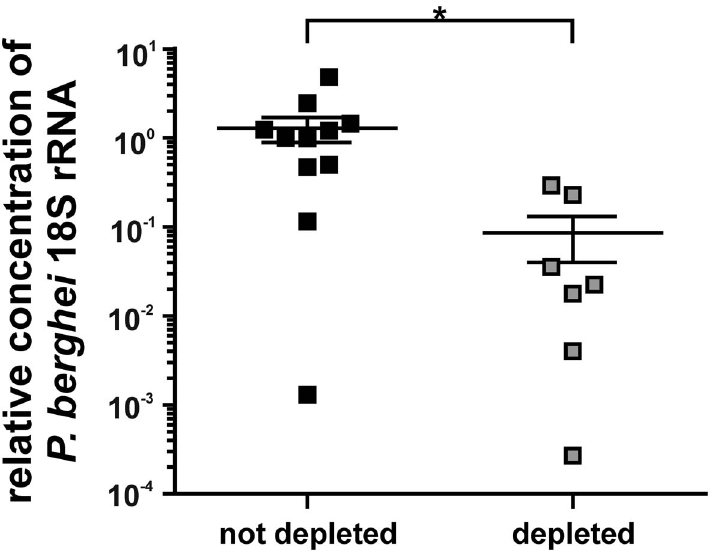
Figure 5. Impact of T reg depletion in parasite burden in the liver. Female Balb/c wild type and DEREG mice were immunized with 20 m g ACT- CSP i.p. on day –7. DT was applied on days –6, 2 5 and –4; on day 0 mice were infected with 1000 P. berghei sporozoites i.v. The P. berghei parasite load in the livers was determined 30 h after infection by qPCR. The expression of P. berghei 18S rRNA relative to mouse GAPDH expression is shown as mean + / 2 SEM of n=11 wild type mice and n=7 DEREG mice. Statistical significance was analyzed using the Mann–Whitney